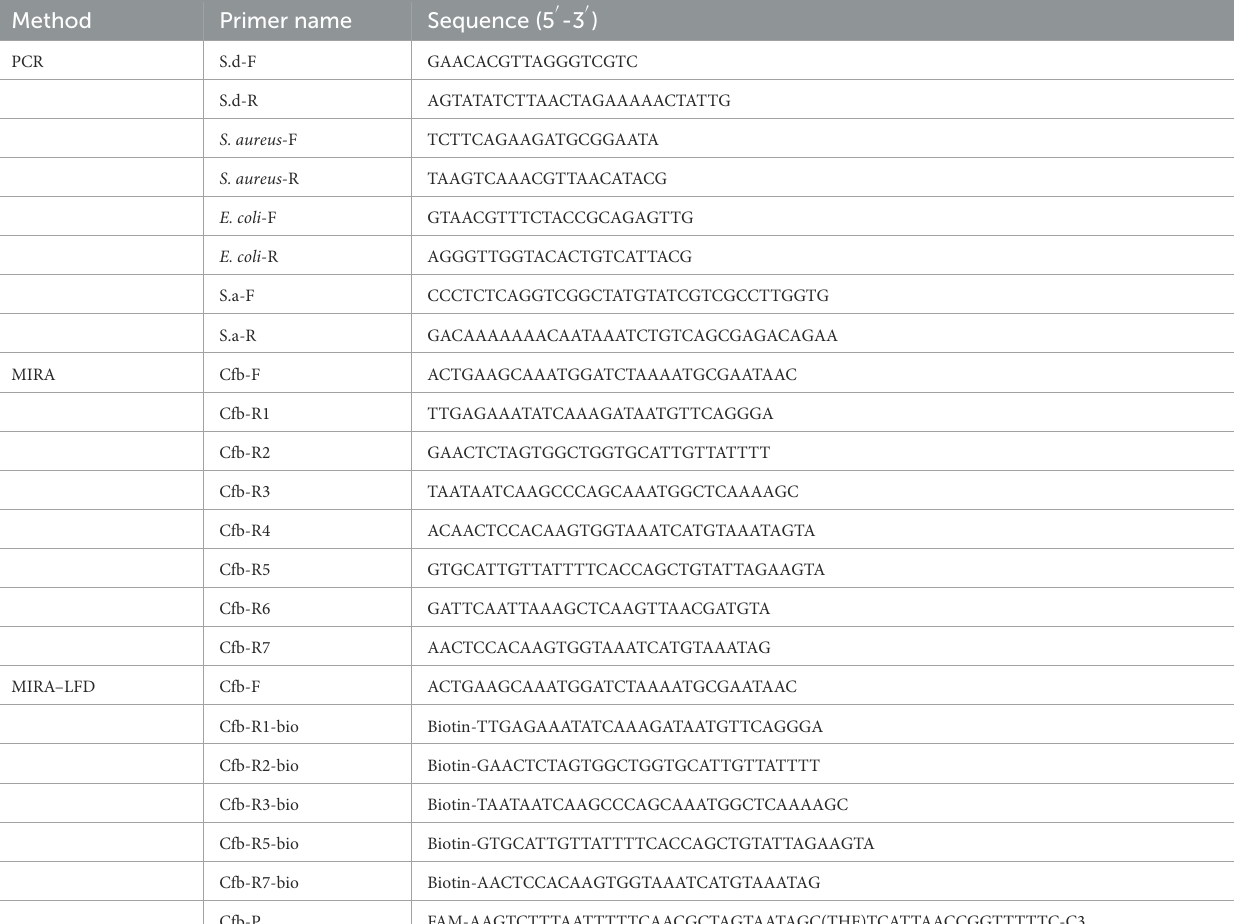
TABLE 1 Primers and probes used in this